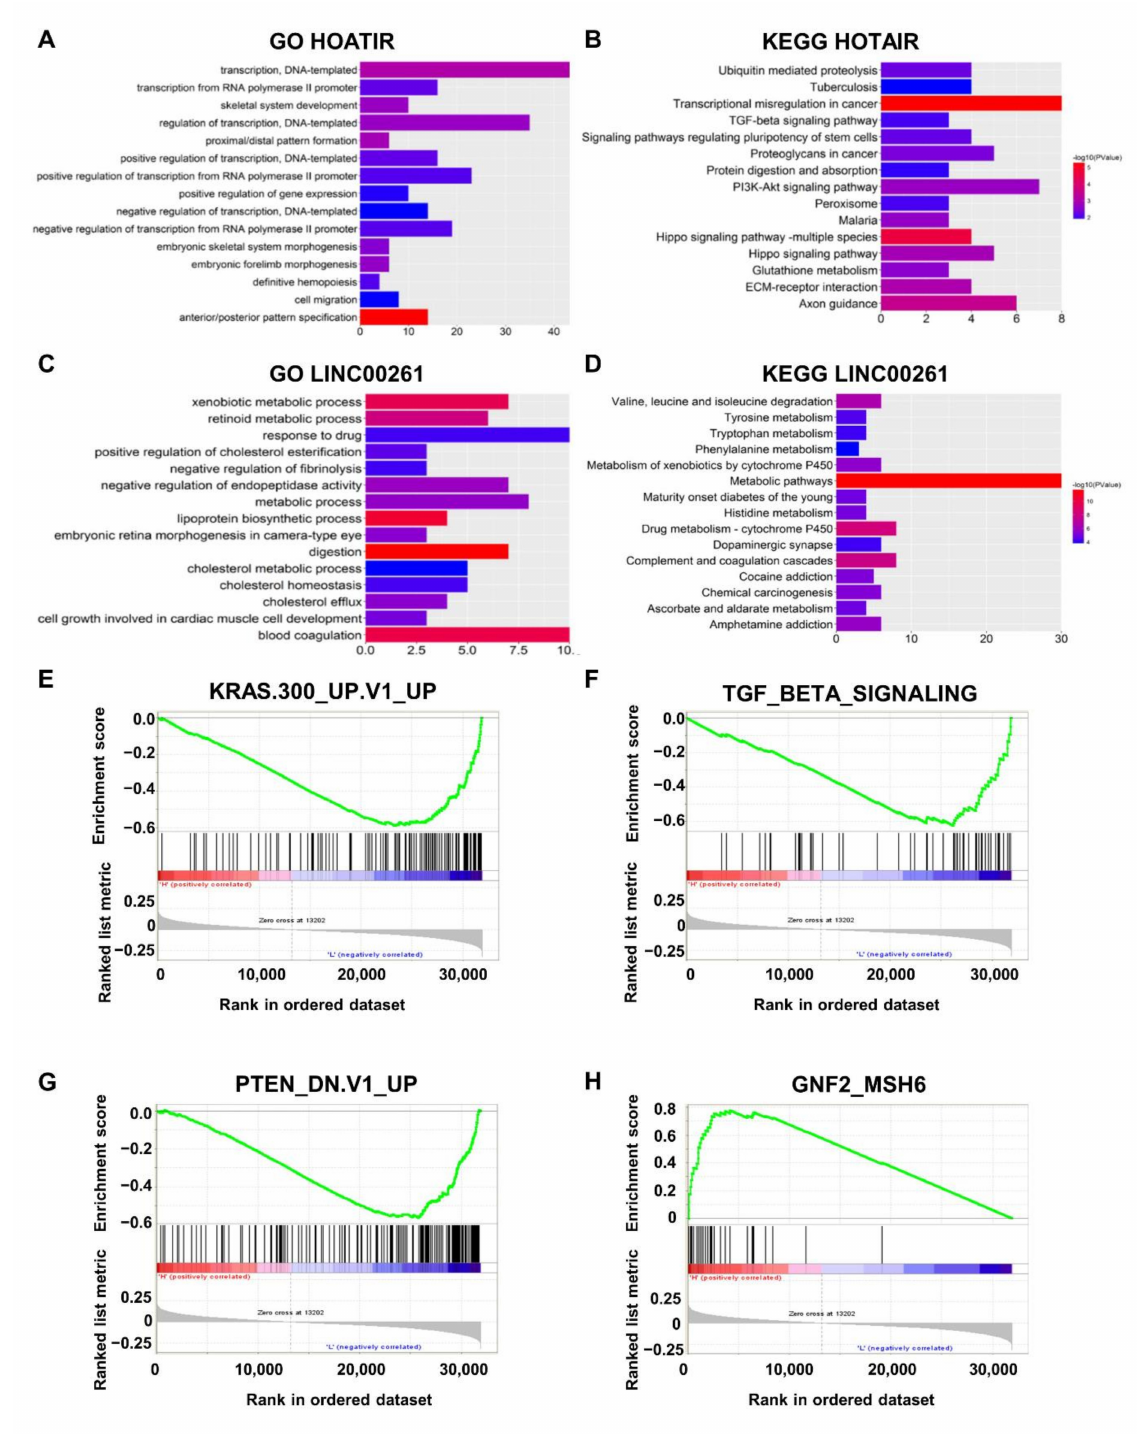
Figure 6. Enrichment analysis of HOTAIR, LINC00261, and LINC00114. ( A , B ) Top 15 GO and KEGG results for coexpressed genes of HOTAIR. ( C , D ) Top 15 GO and KEGG results of the coexpressed genes of LINC00261. Color from blue to red indicates − log10 ( p ) from low to high. X -axes represent the number of genes involved in each pathway. ( E , F ) The gene sets “KRAS.300_UP.V1_UP” ( p < 0.0001) and “TGF_BETA_SIGNALING” ( p = 0.002) were significantly enriched with low levels of LINC00114. ( G ) The gene sets “PTEN_DN.V1_UP” ( p < 0.0001), which included genes upregulated upon knockdown of PTEN, were significantly enriched with low levels of LINC00114. ( H ) The gene set “GNF2_MSH6” ( p = 0.018) was enriched with high levels of